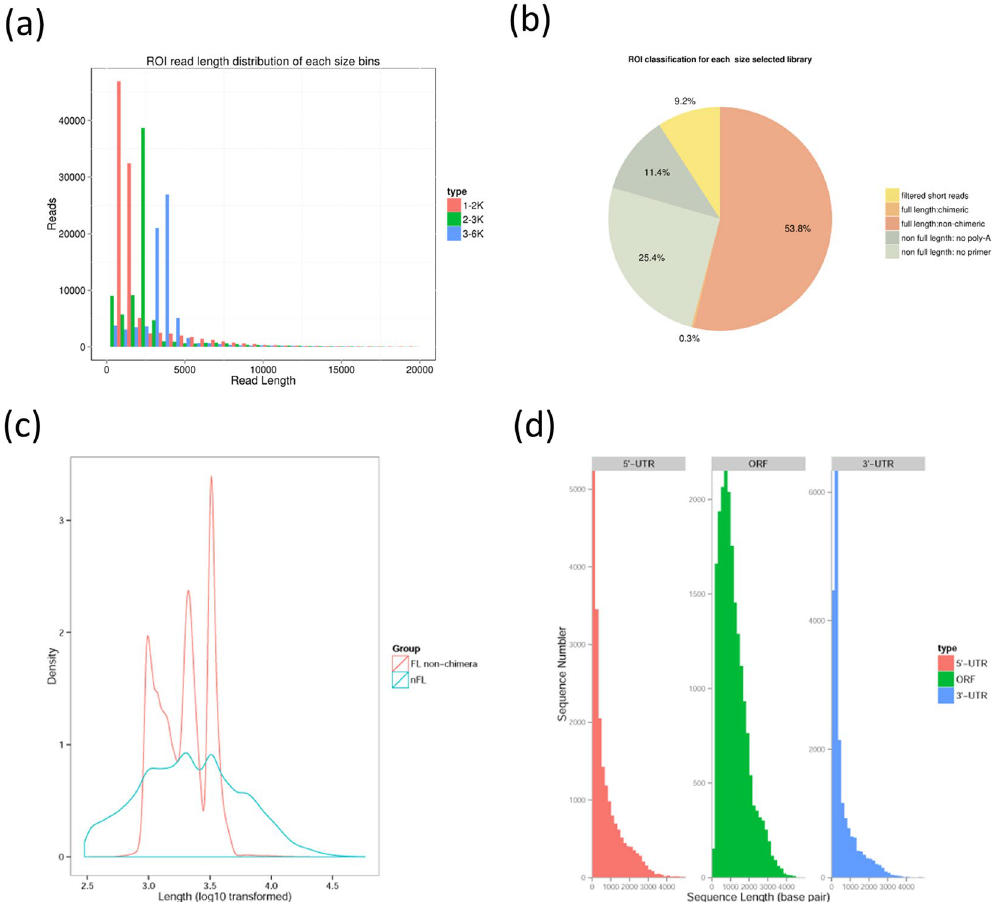
Figure 1. Summary of PacBio RS II SMRT sequencing. ( a ) ROI length distribution in Z . japonica from different PacBio libraries with fractionated sizes of 1–2, 2–3, and 3–6 kb. (b) Proportion of different types of PacBio reads in Z . japonica . ( c ) Categorization of ROIs after error correction using Illumina short reads according to the locations of the erroneous fragments. (d) Number and length distributions of the 20,032 non-redundant full- length